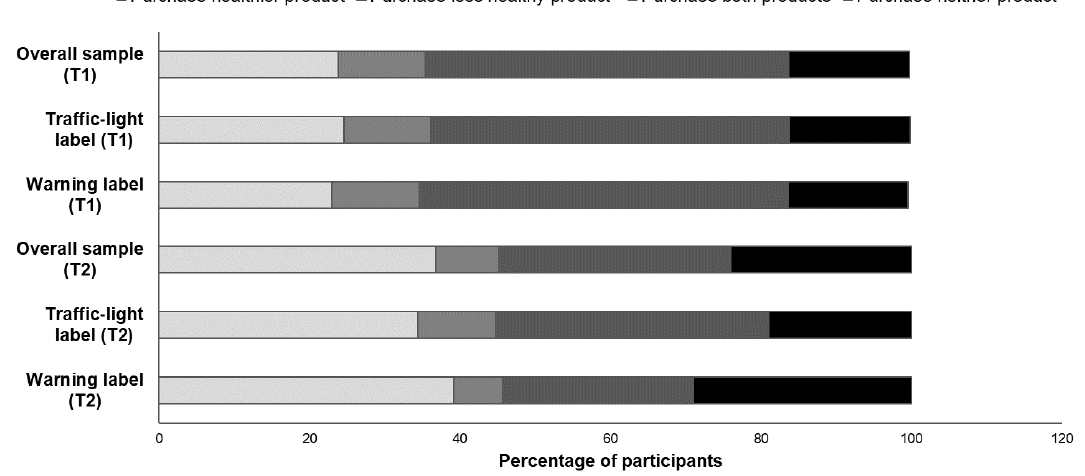
Figure 5. Intention to purchase, measured in a product comparison task; p < 0.001 for differences between label conditions at T2.